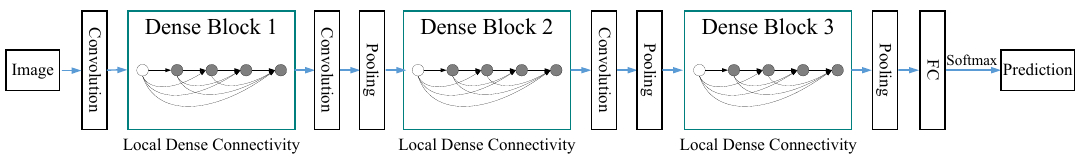
Figure 2. Flowchart of image classification based on DenseNet [48]. Note that only layers within each block are densely connected, presenting a local dense connectivity